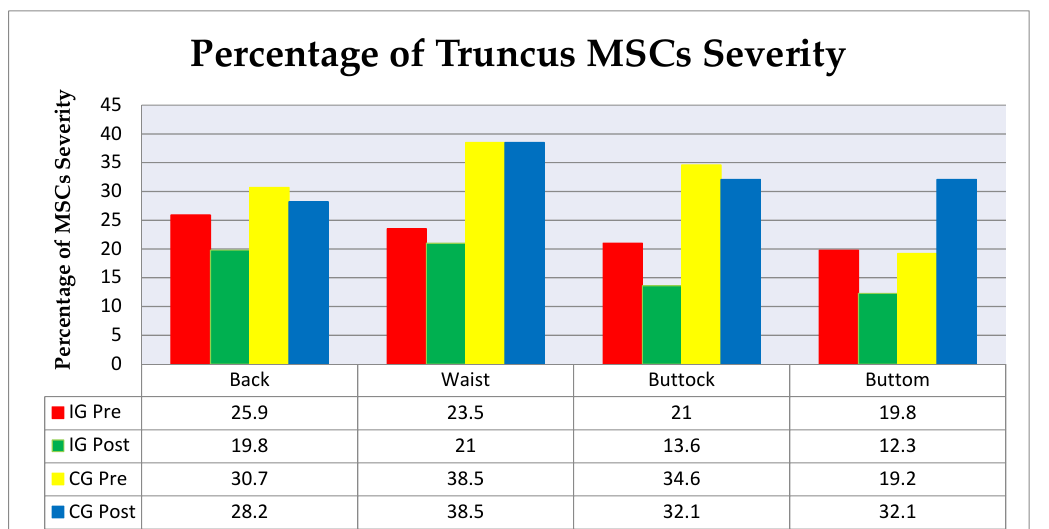
Figure 5. Percentage of truncus MSC severity. IG Pre—intervention group before the intervention; IG Post—intervention group after the intervention; CG Pre—control group before the intervention; CG Post—control group after the intervention.